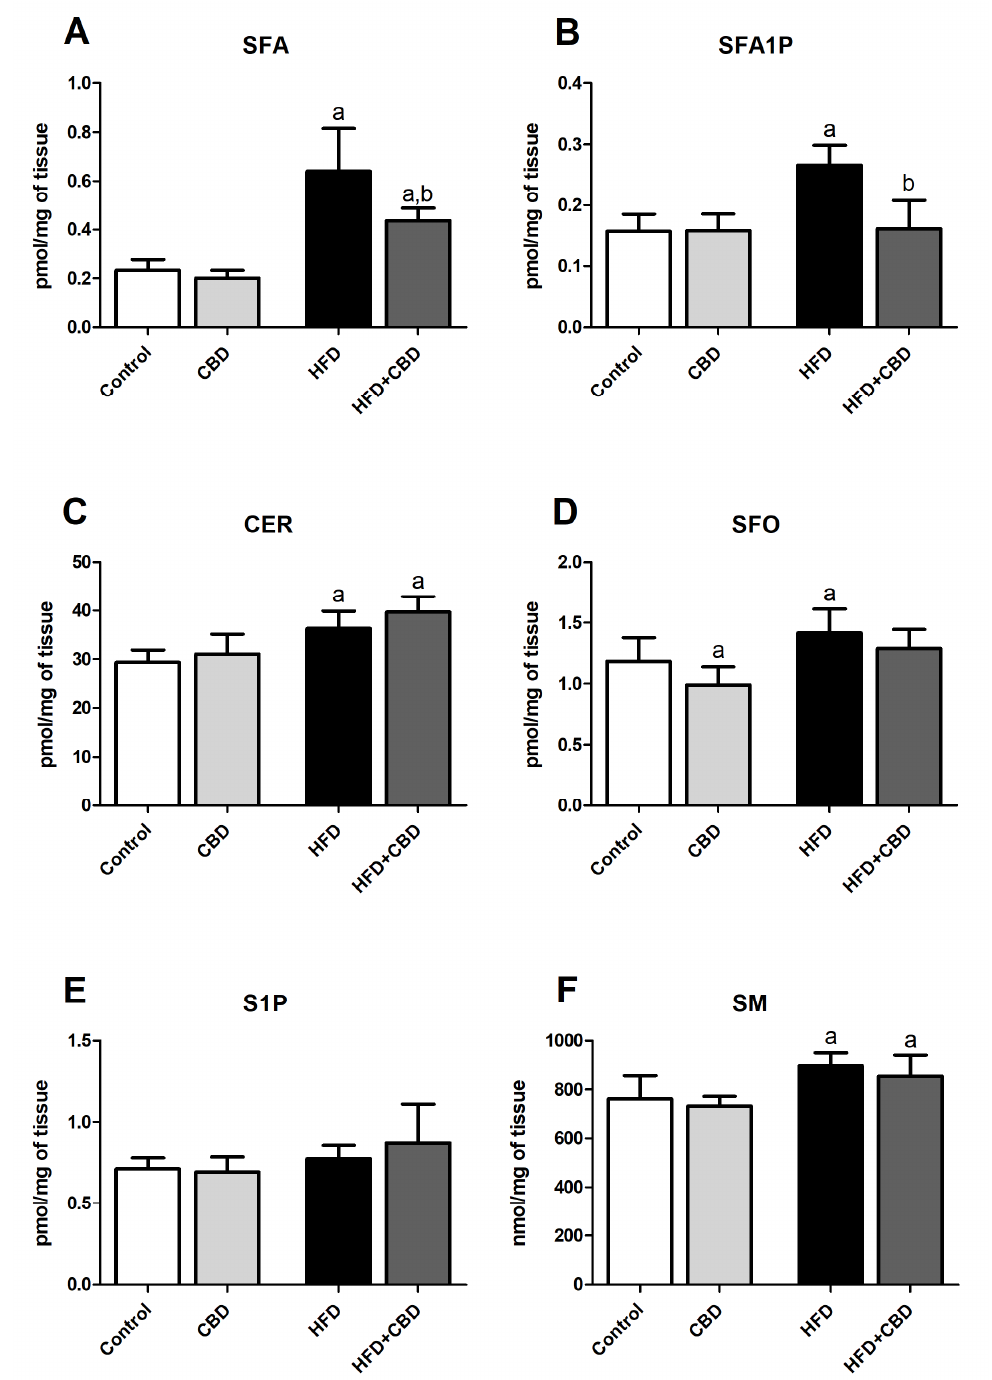
Figure 4. The content of myocardial sphingolipids, i.e., sphinganine—SFA ( A ), sphinganine-1- phosphate—SFA1P ( B ), ceramide—CER ( C ), sphingosine—SFO ( D ), sphingosine-1-phosphate—S1P ( E ), and sphingomyelin—SM ( F ) in the left ventricle tissue after 2-week cannabidiol (CBD) adminis- tration in rats fed a standard diet (Control) or a high-fat diet (HFD). The contents of sphingolipid pathway components were measured by high-performance liquid chromatography (HPLC) and gas-liquid chromatography (GLC) methods. The results are expressed as mean values ± SD and are based on ten independent determinations in each experimental group. a p < 0.05 significant difference vs. control group; b p < 0.05 significant difference vs. high-fat-fed